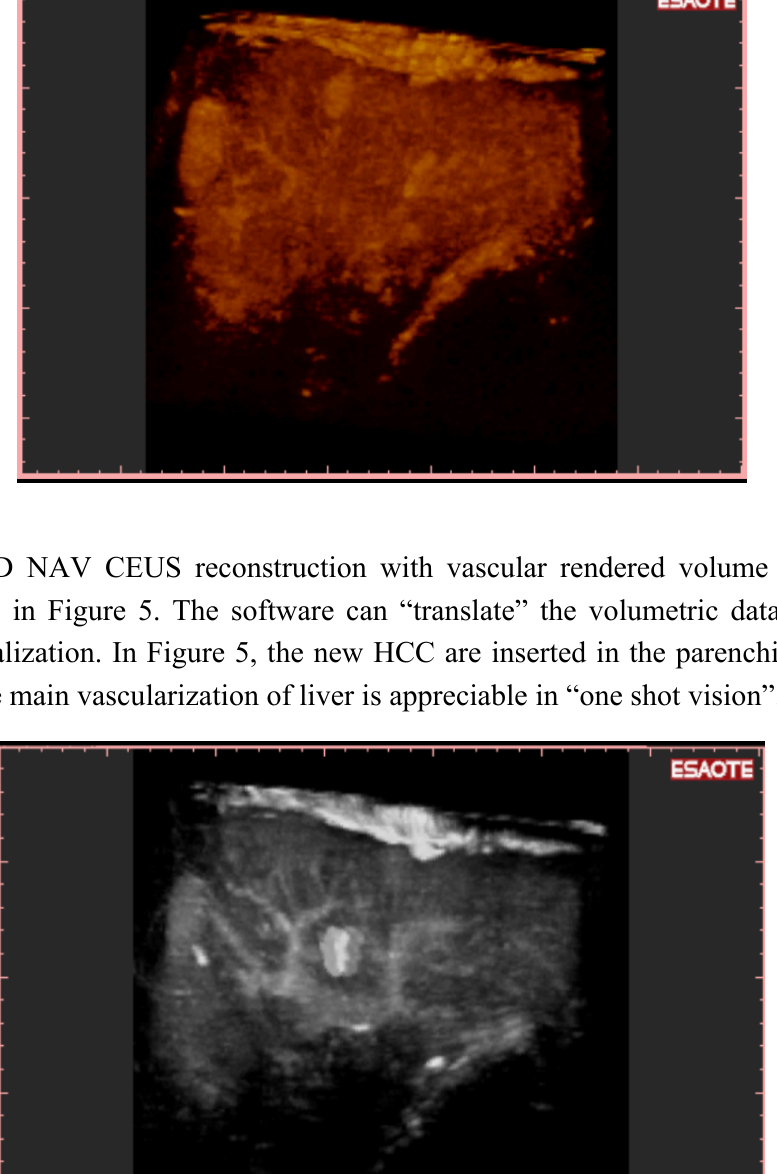
Figure 5. 3-D NAV CEUS reconstruction with parenchymal rendered volume: Two new HCC in different liver segments are evident. This kind of reconstruction is able to show HCC nodules inside liver parenchyma; this is performed offline with the software (inside TECHNOS MPX) specific for 3-D rendering.